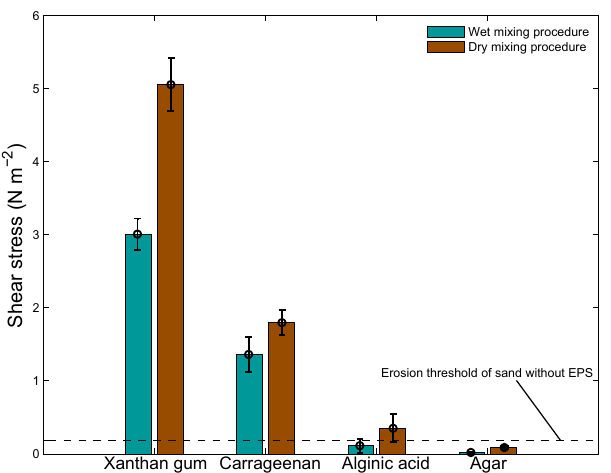
Figure 5. The erosion thresholds as a function of the preparation procedure for four surrogates as measured with the CSM erosion device. Error bars are standard deviations from n = 5 repeat mea- surements.